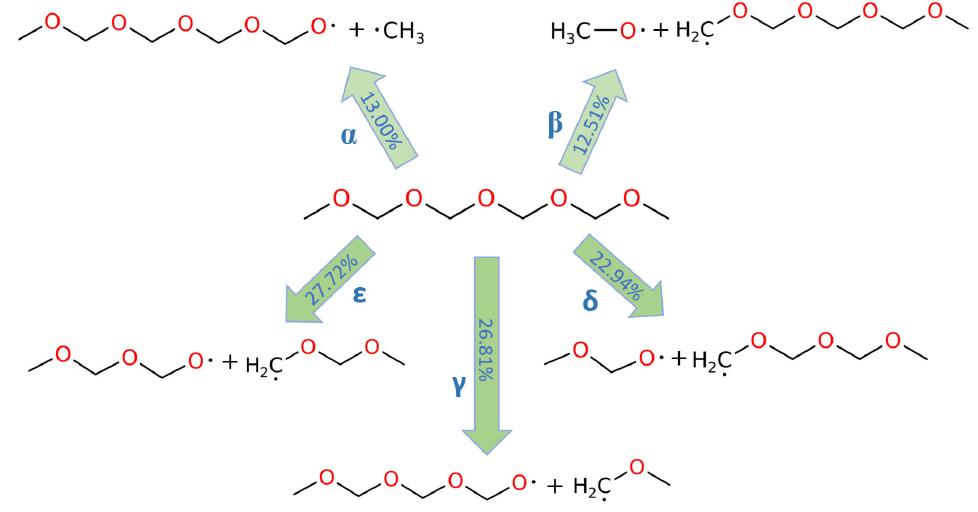
Figure 3. C-O bond dissociation in PODE4 at 3000 Figure 3. C ‐ O bond dissociation in PODE4 at 3000 K.